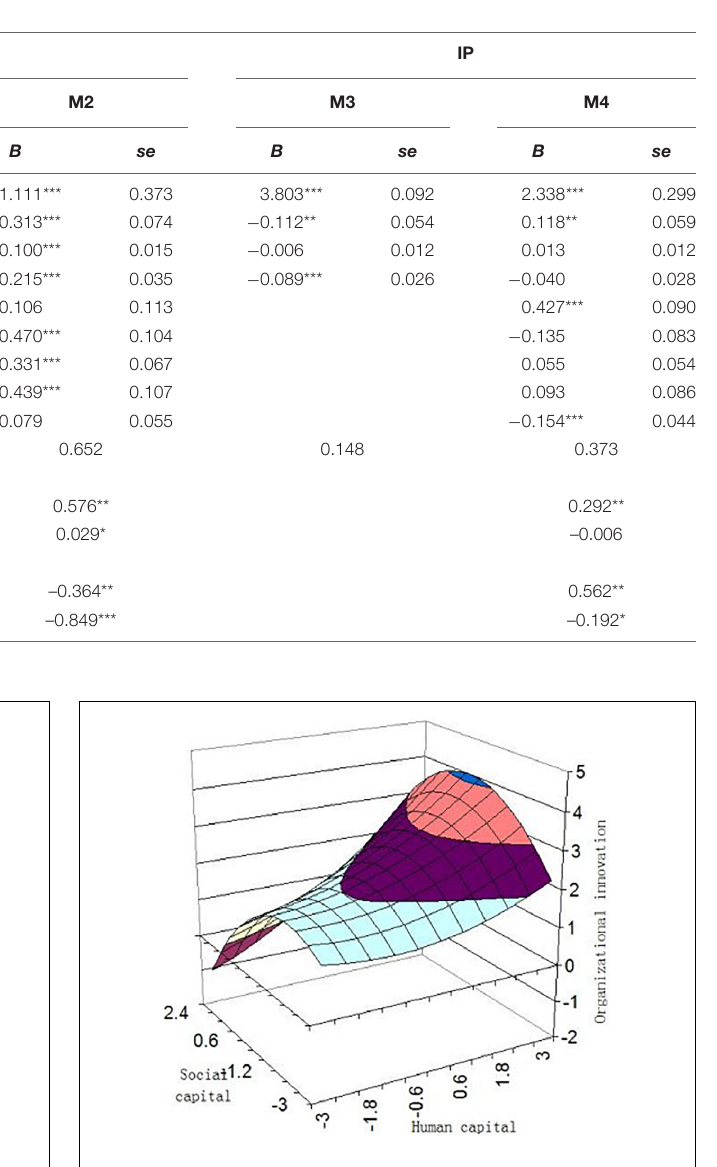
FIGURE 3 | Dynamic of encouragement as predicted from capital. FIGURE 4 | Organizational innovation as predicted from